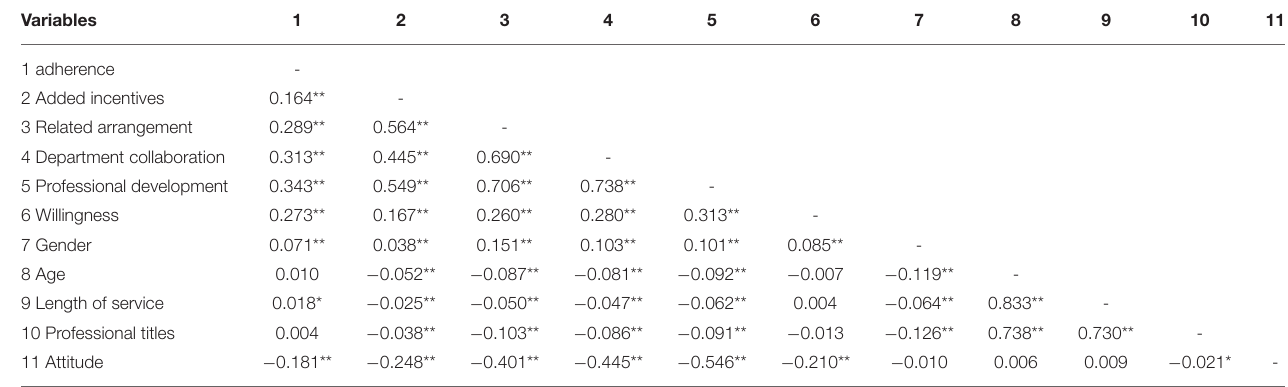
TABLE 3 | Correlations of variables.